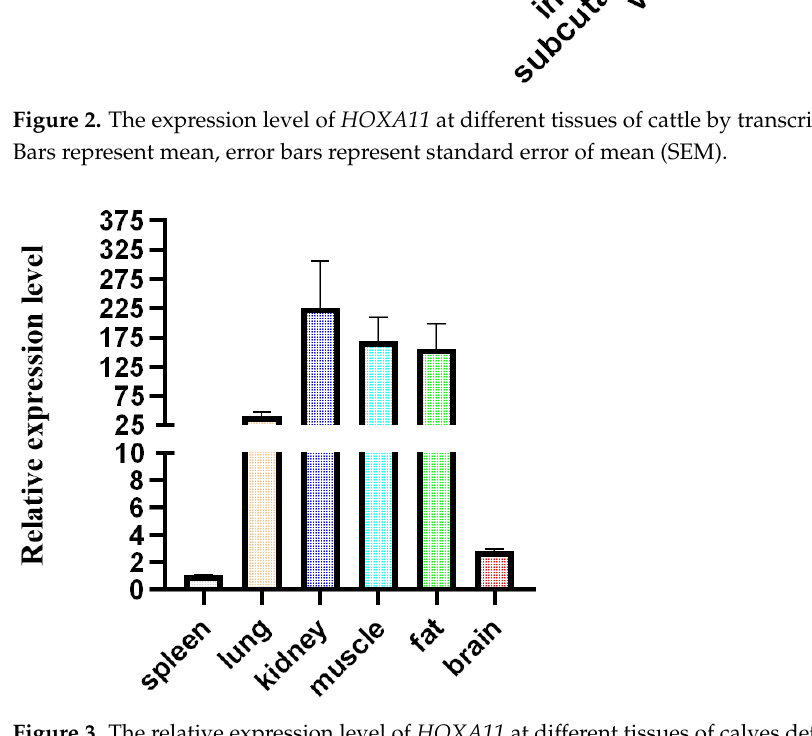
Figure 3. The relative expression level of HOXA11 at different tissues of calves detected by qRT-PCR. Bars represent mean, error bars represent standard error of mean (SEM).